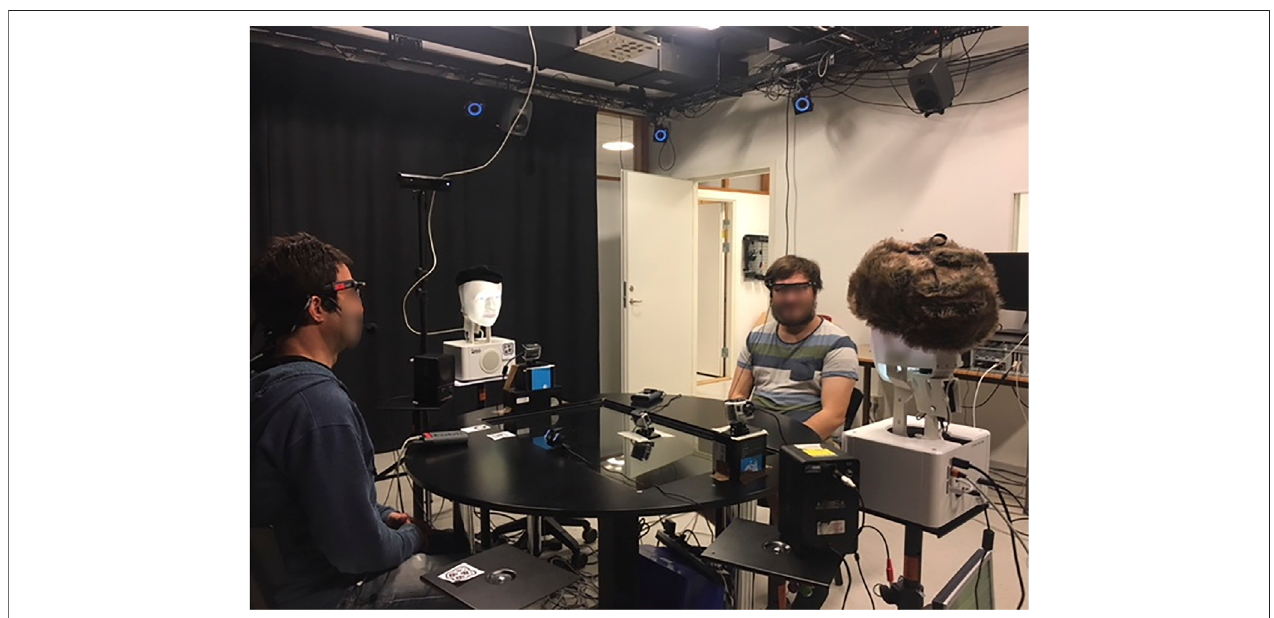
FIGURE 4 | The experimental setup for the evaluation of the proposed data-driven arti fi cial listener, in comparison to the baseline system.